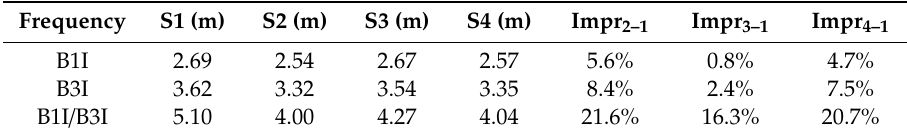
Table 8. RMS and improvement of the BDS SPP for different schemes. Impr j-i indicates the positioning